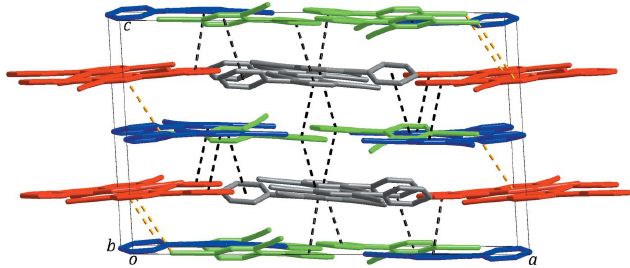
Figure 4 The supramolecular framework formed via intermolecular (cid:2) - (cid:2) stacking (black dashed lines) and C N (cid:2)(cid:2)(cid:2) (cid:2) (yellow dashed lines) interactions involving the four independent molecules (colour codes: gray = molecule A , red = molecule B , blue = molecule C and green = molecule D ). All H atoms have been omitted for clarity.